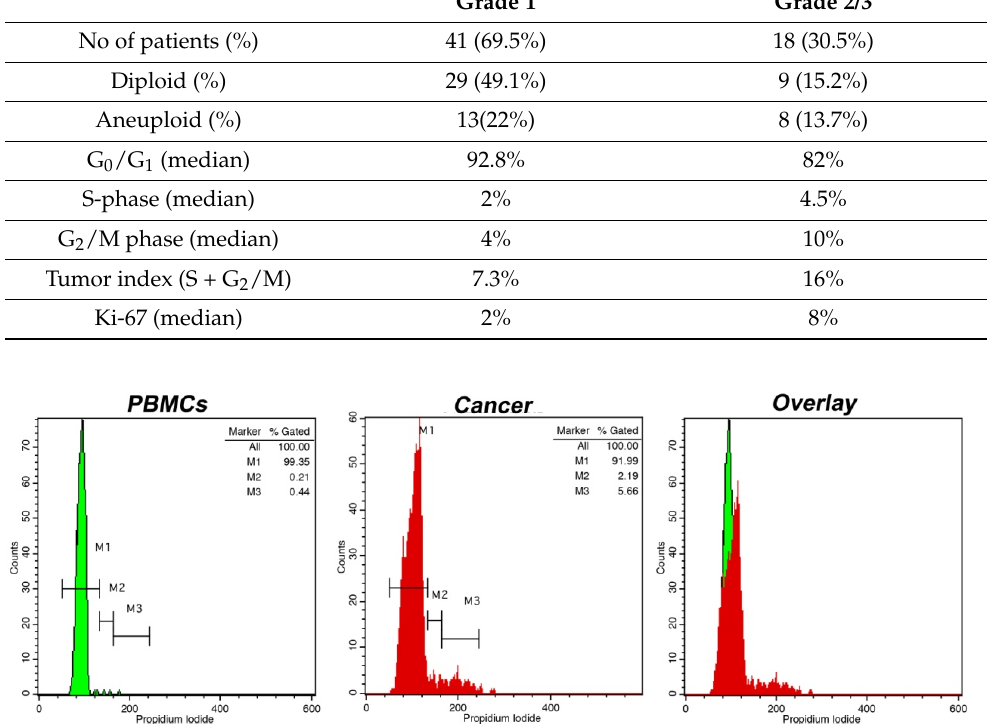
Figure 2. Cell cycle distribution analysis using intraoperative flow cytometry in a higher-grade men- ingioma. PBMCs and cancer cells are represented as in Figure 1, with respective markers M1, M2 and M3 representing G 0 /G 1 , S and G 2 /M cell cycle phases (presented as quantified in the top right corner of each histogram). The case exhibits a DNA index = 1 and a tumor index = 29%. In the overlay histogram, the G0/G1 peak of cancer cells in red is discernible from that of normal cells in green.